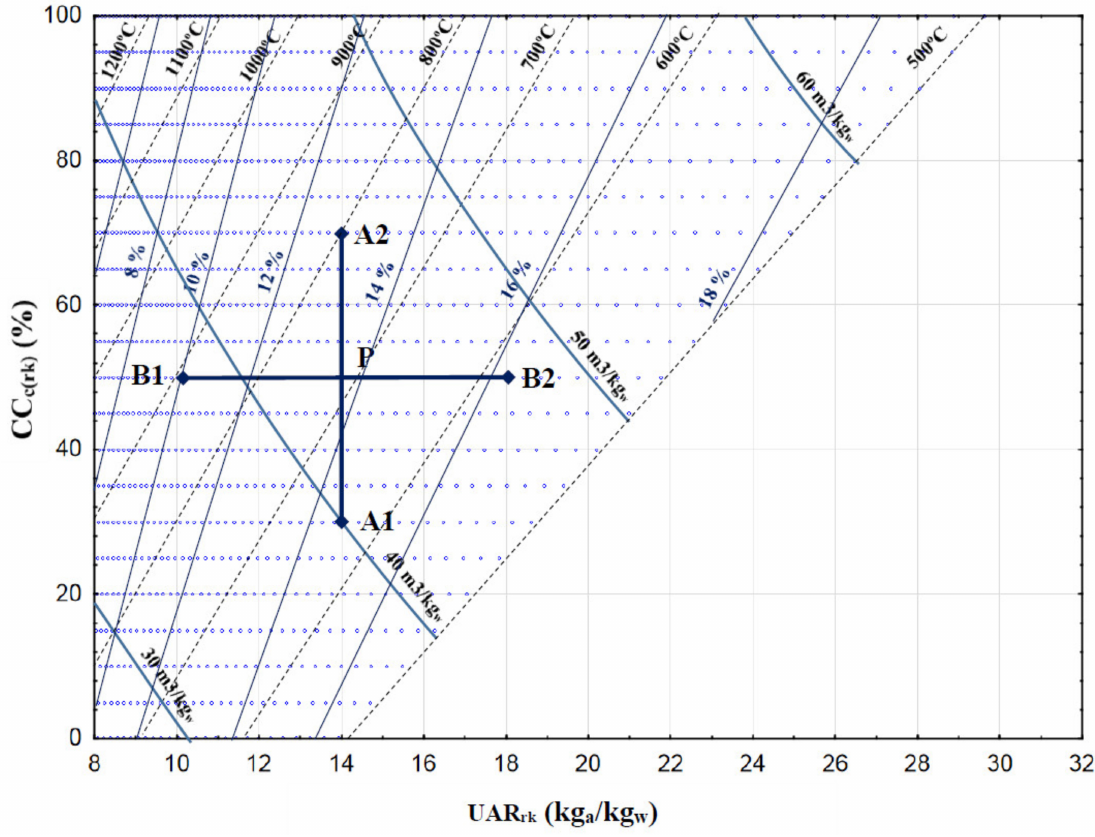
Figure 3. Chart of variability of process parameters in the rotary combustion